Question: How would you classify this visualization?
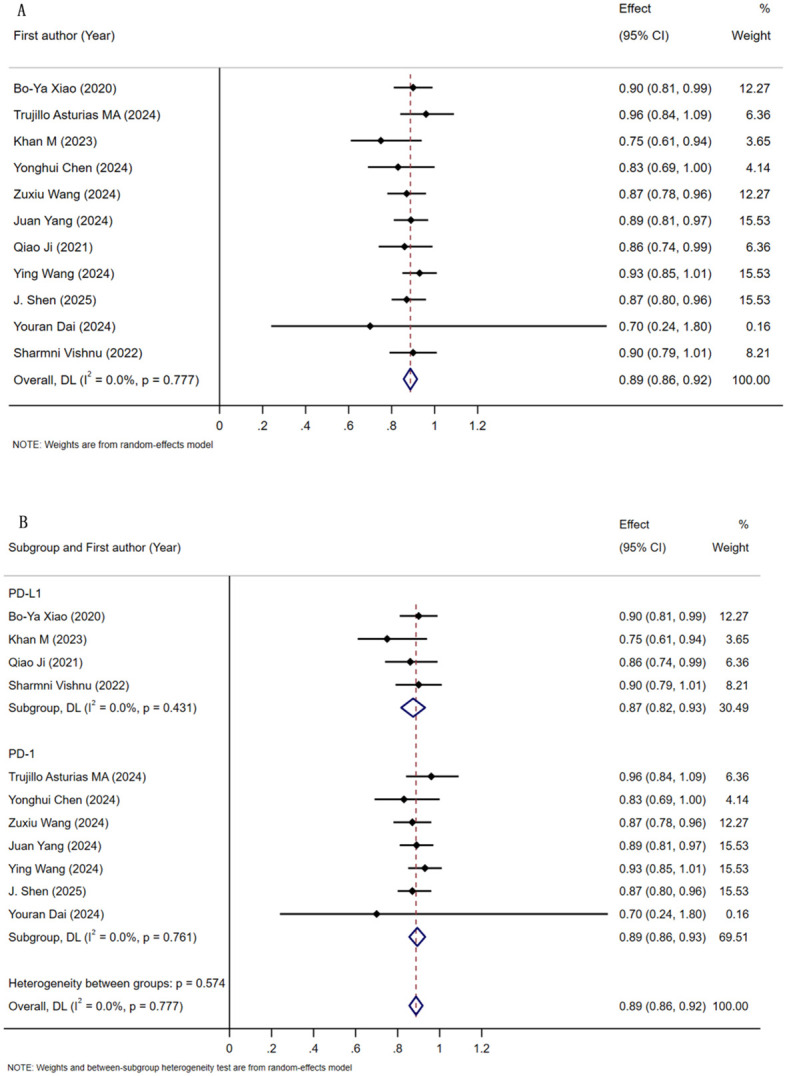
Answer: forest